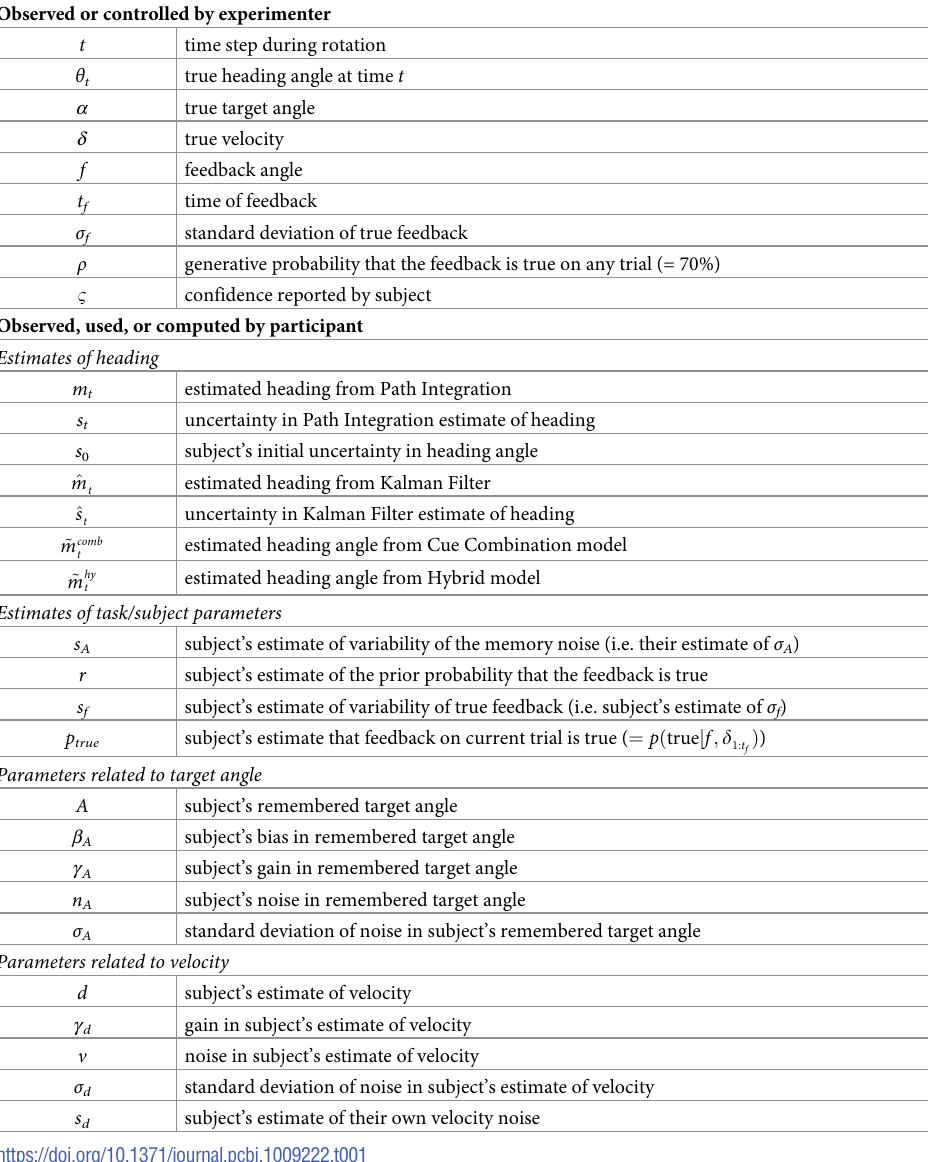
Table 1. Glossary of key variables in the